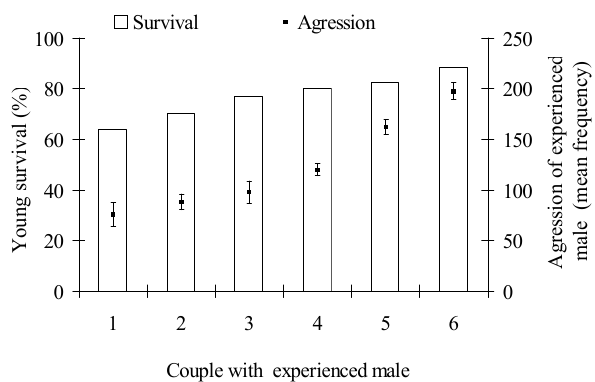
Fig. 3. Survival of the larvae in relation to experienced male aggressiveness (Pearson, p <